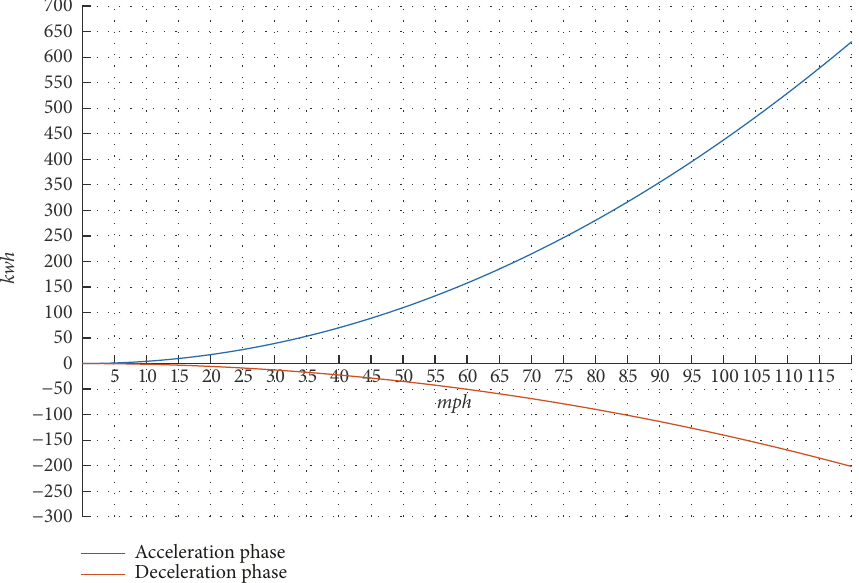
Figure 2: The energy loss during acceleration phase and deceleration phase related to velocity.